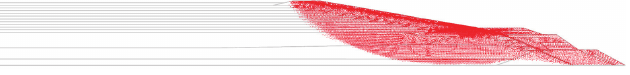
Figure 19: Failure zone of the dam after shaking with normal earthquake.